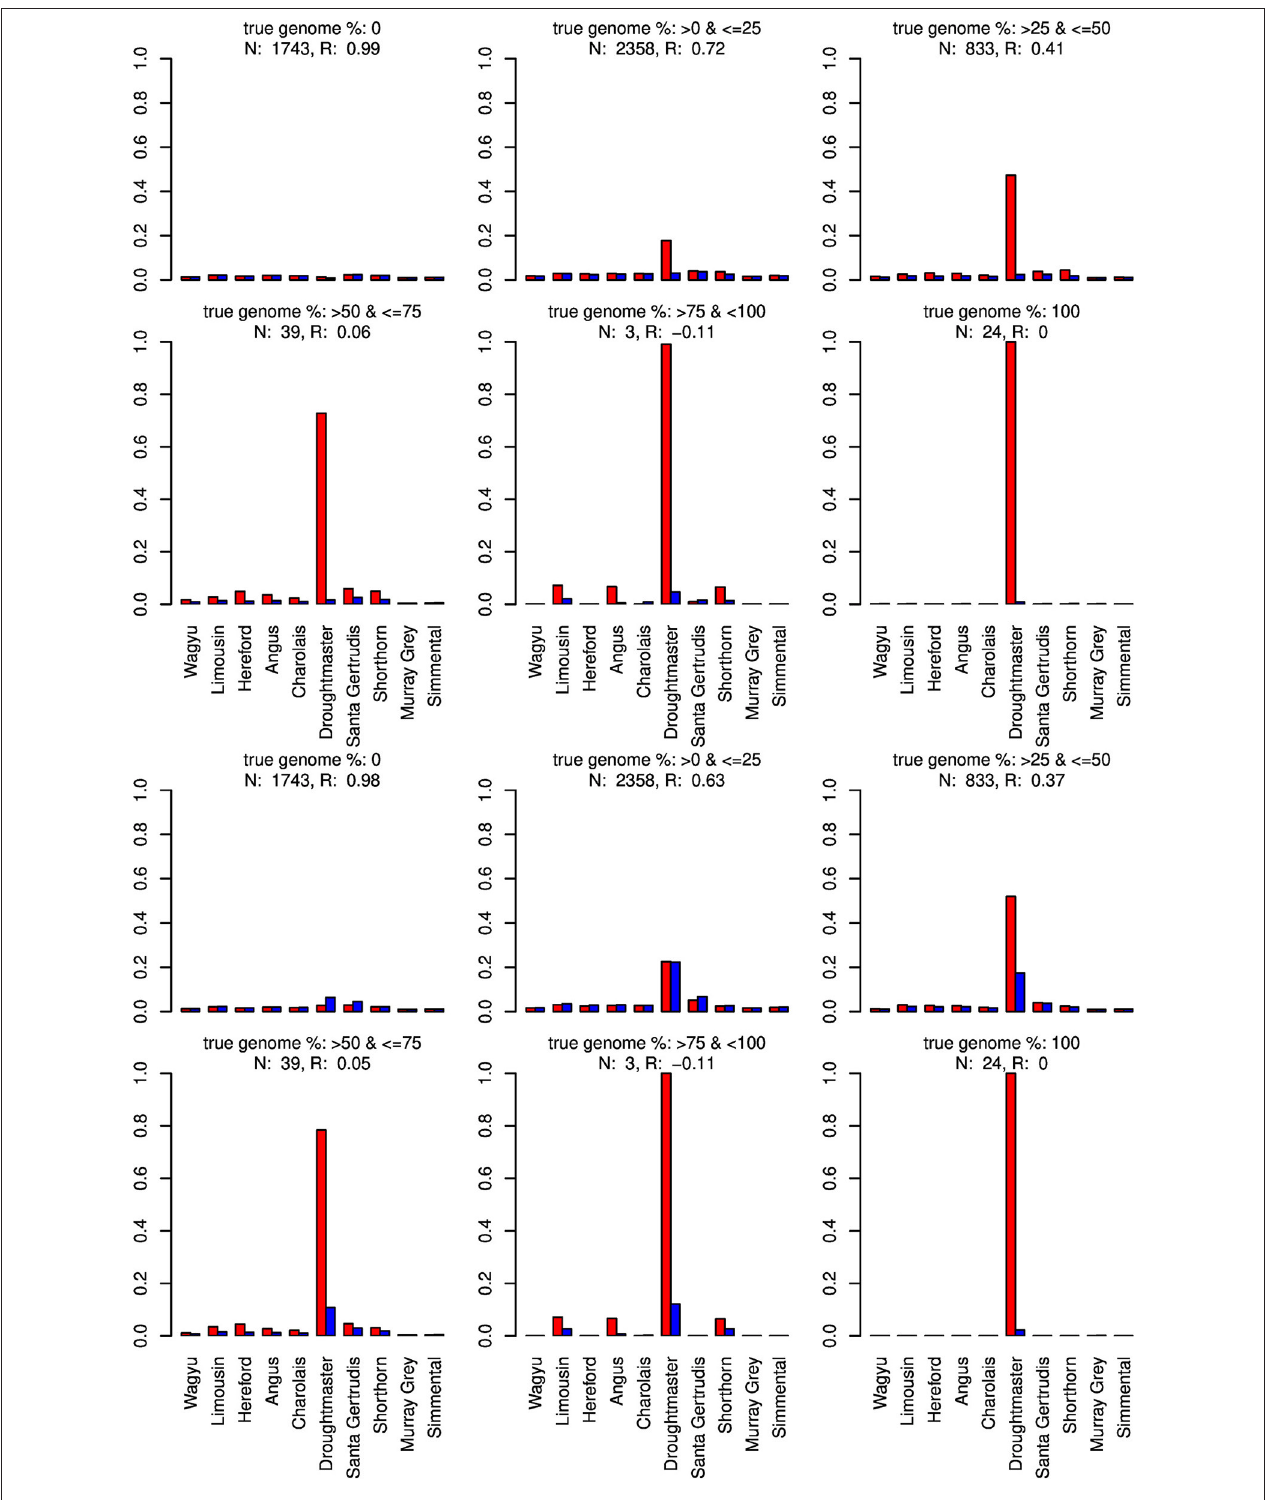
FIGURE 7 | Distribution of the average absolute estimation error within possible founder breeds for the 25 cross-over cattle data set from a model using all 11 breeds (blue) and a model excluding the Brahman breed (red). Results are shown for categories of artificially admixed animals having 0%, > 0%– ≤ 25%, > 25% −≤ 50%, > 50%– ≤ 75%, > 75%– < 100%, and 100% genome of the excluded breed. The graphs in the upper two rows show the results from CGR the lower two rows those from ADMIXTURE. R, correlation between the true and the estimated genome proportion when the Brahman breed was excluded; N, number of used admixed individuals for calculating